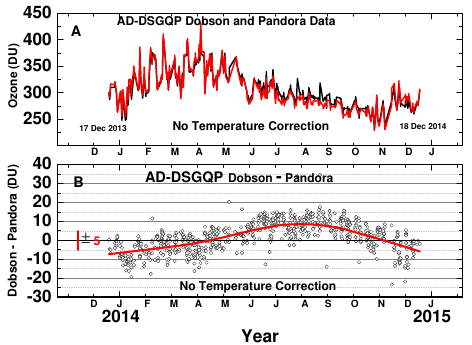
Figure 1. (a) Retrieved AD-DSGQP TCO data obtained from Dob- son #061 and Pandora #34 atop the NOAA building in Boulder, Colorado, for ± 8min average of TCO(Pan) about the Dobson mea- surement time. (b) The difference TCO(Dobson) – TCO(Pandora), showing a change in bias as a function of season without temper- ature correction. The standard deviation from the red Lowess (0.5) curve is ± 5DU. In this and subsequent graphs, the abscissa labels are for the first day of each month from 1 December 2013 to 1 Jan- uary